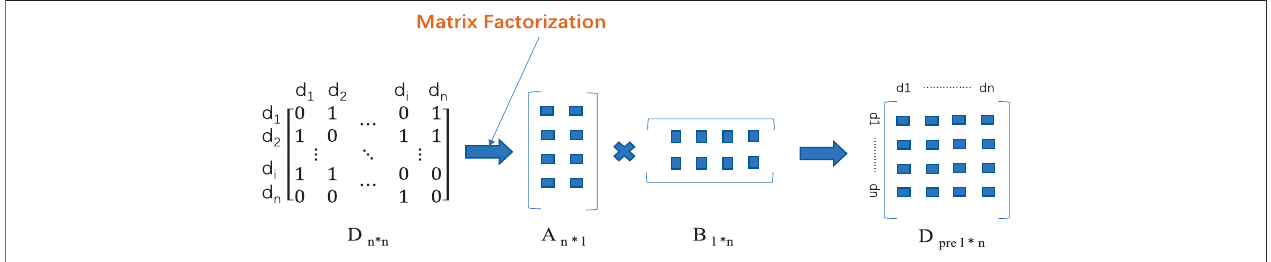
FIGURE3| Theprocessofmatrixfactorizationmethod.Firstly,thematrixD n*n ofknownDDIisconstructed,andthematrixDisdecomposedintoA n*l andB l*n by different matrix factorization methods. Multiply the two resulting matrices, and you get the matrix D pre l * n that predicts